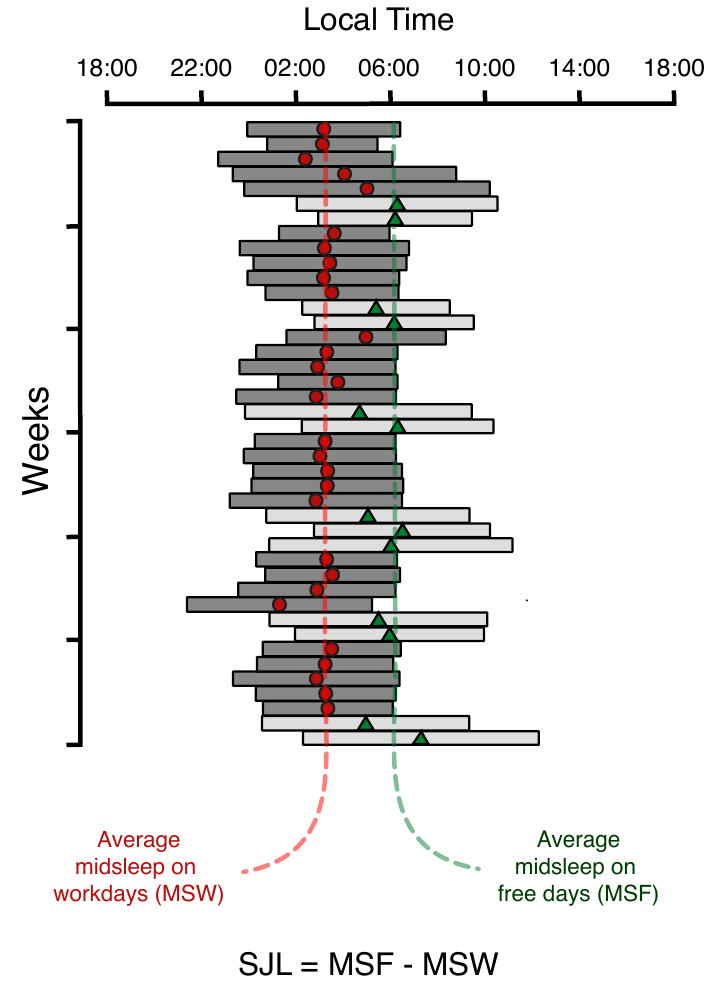
Figure 3. This sleep-log example clearly shows the weekly structure in both sleep timing and duration, which we use as the basis for quantifying social jetlag (SJL). Workday-sleep episodes are dark gray and free day episodes are drawn in light gray. The di ff erence between the average of the midsleep points on workdays (red dots) and those on work-free days (green triangles) is defined as SJL and used as a measure for circadian misalignment (see text for